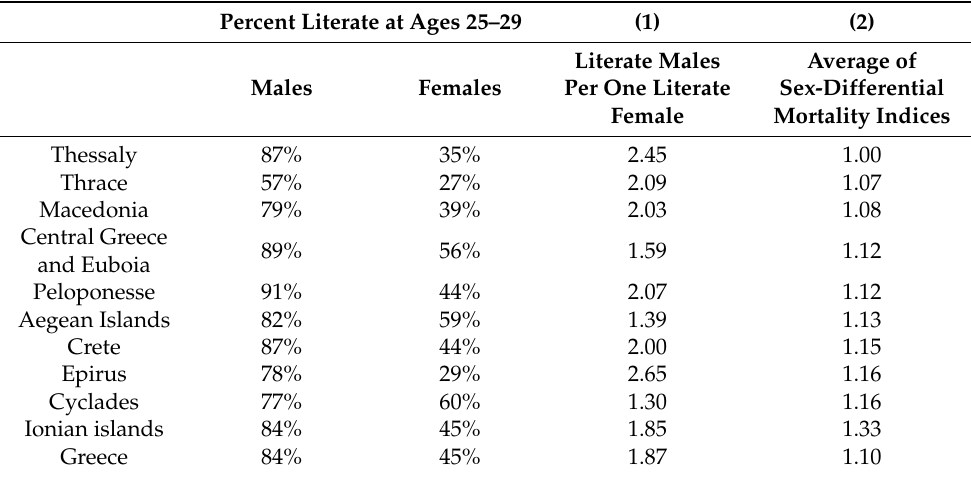
Table 2. Literacy status and sex-differential